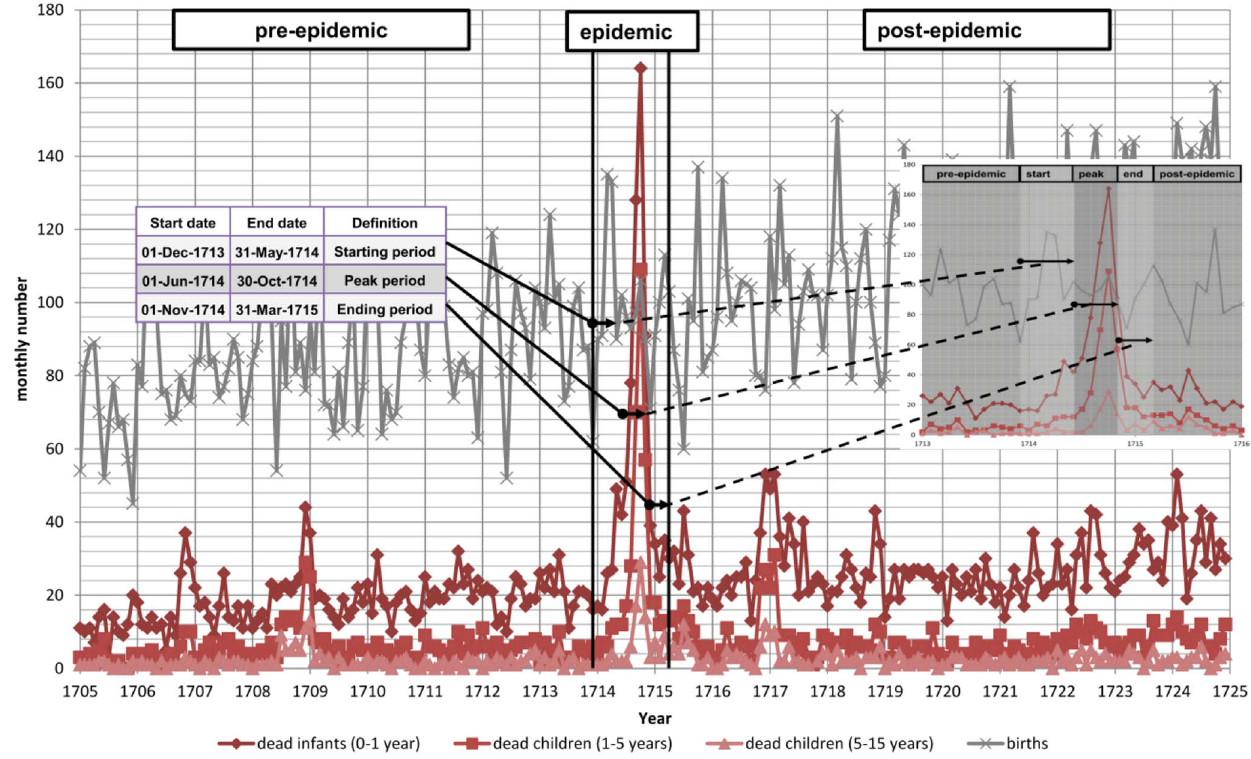
Figure 1. Monthly number of births, dead infants (0–1 year), small children (1–5 years), and children (5–15 years) from 1705 until 1724, and classification of the measles epidemic 1714–15 into a pre-epidemic, starting, peak, ending, and post-epidemic period.